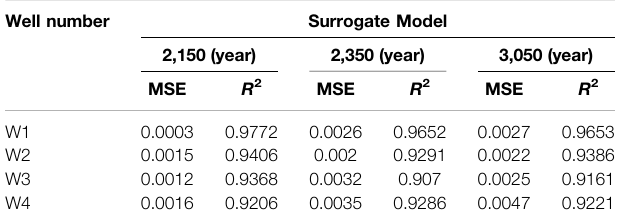
TABLE 3 | Water level errors between surrogate models and groundwater fl ow models. Well number